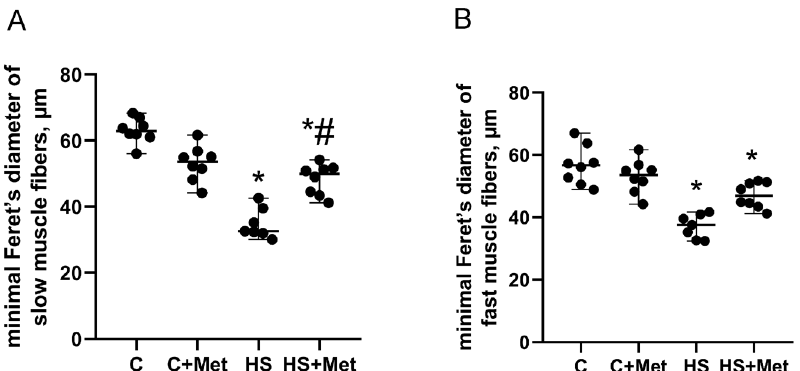
Table 3. Changes in the absolute and normalized twitch and tetanic tension in the isolated rat soleus muscle.